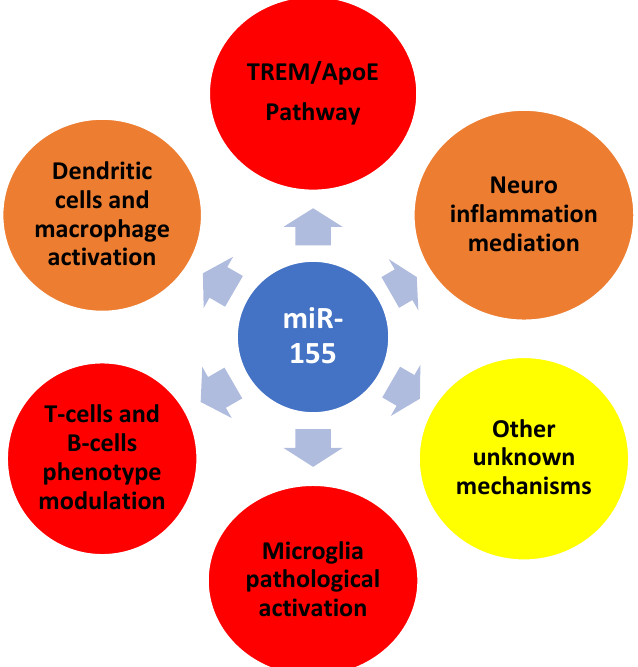
Figure 2. The cellular and molecular pathways/targets explaining the impact of miRNA (focus on miR-155) in Alzheimer’s disease. (Color coding: blue—promoting factor; red—negative impact; orange—negative or positive impact (related to other biological variables); and yellow—unknown).